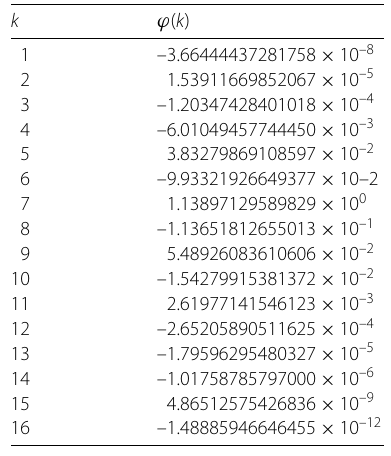
Table 1 Some values of generalized Coiflet scaling function for N = 6 and M 1 = 7 k ϕ ( k )